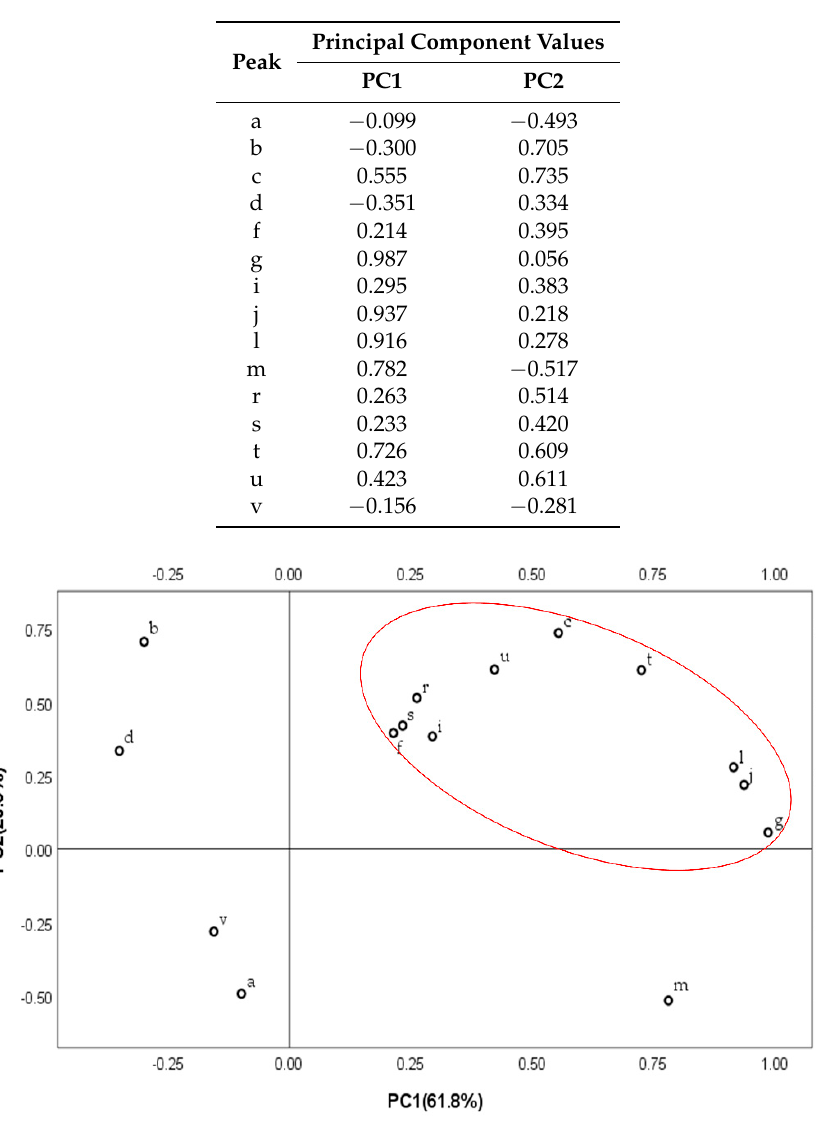
Table 4. Factor loading matrix of tested samples.